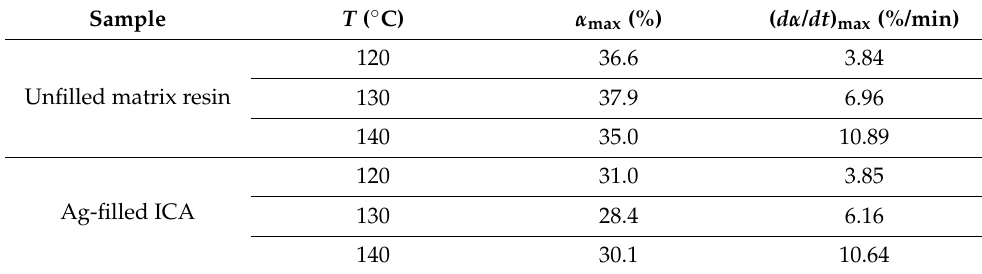
Table 3. Data obtained from the relationship between d α / dt and α as obtained in